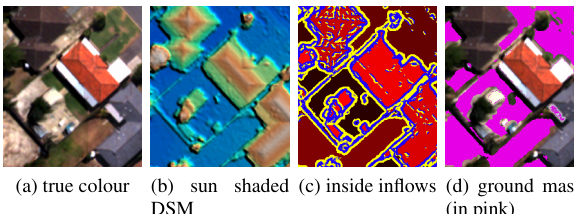
Figure 3. An example of the inflows segmentation filter in action. Using the DSM (b) (hot/grey colours correspond to high DSM values), the area was segmented into pixels above or below the slope threshold (c). In (c) pixels that would ‘flow’ into a neigh- bouring region are yellow , and pixels that would ‘flow’ away from a neighbouring region are blue . In (c) the level segments are coloured with various saturations of red; the less saturated (darker) a segment the higher the proportion of inward flowing pixels. The segments with more than 50% of their boundary pix- els flowing inwards were then labelled ground (d) (ground pixels are coloured